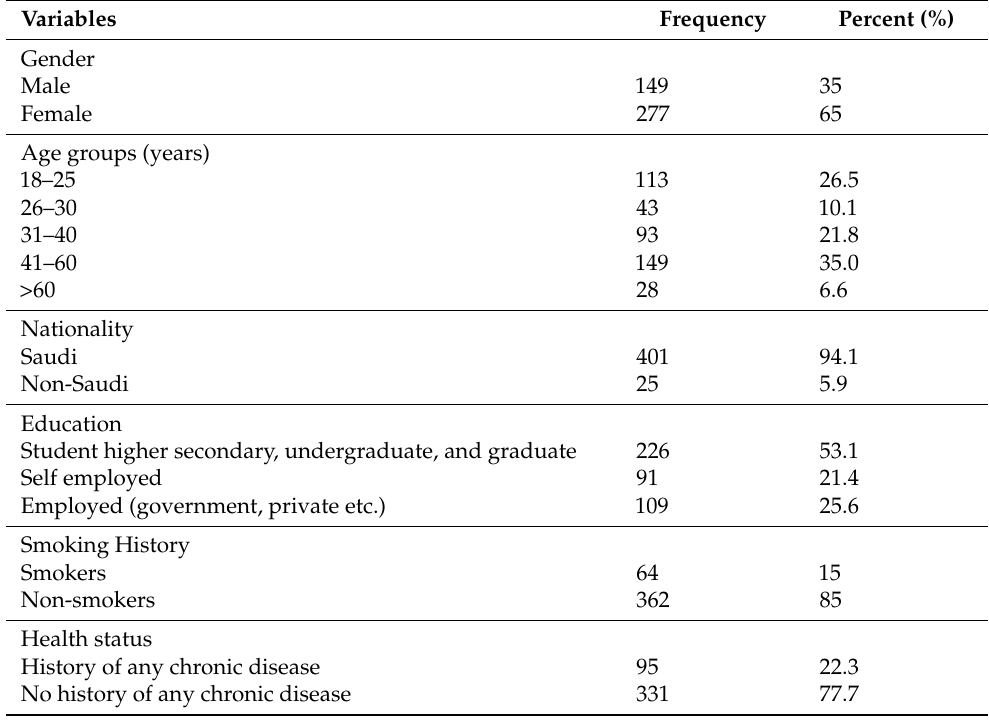
Table 1. The demographic characteristics of the study participants (n =